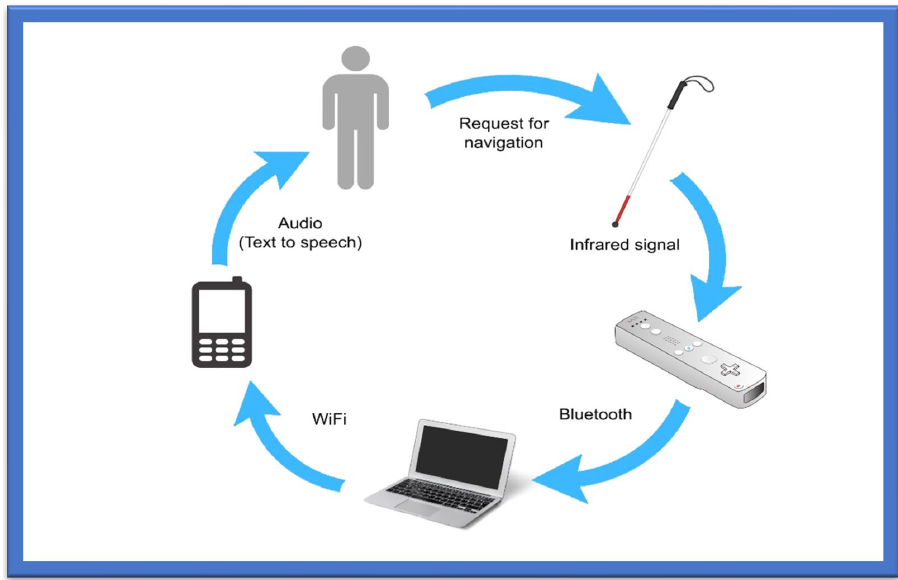
Figure 5. Augmented White